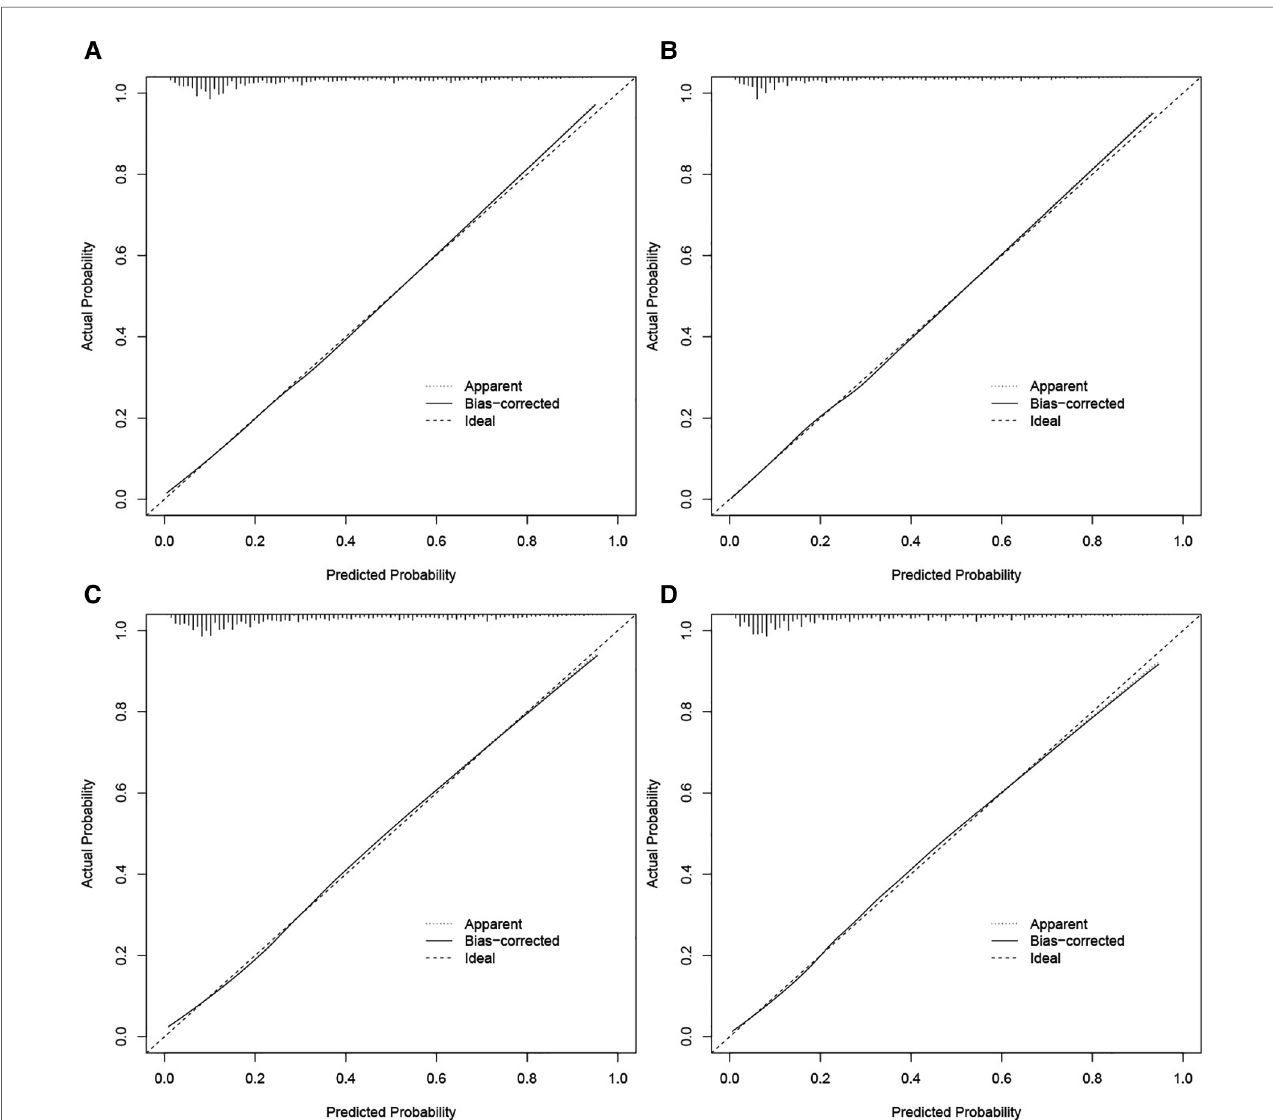
FIGURE 3 Calibration curves for the nomogram in predicting all-cause and cancer-speci fi c early death in the training cohort ( A,B ) and the validation cohort ( C,D